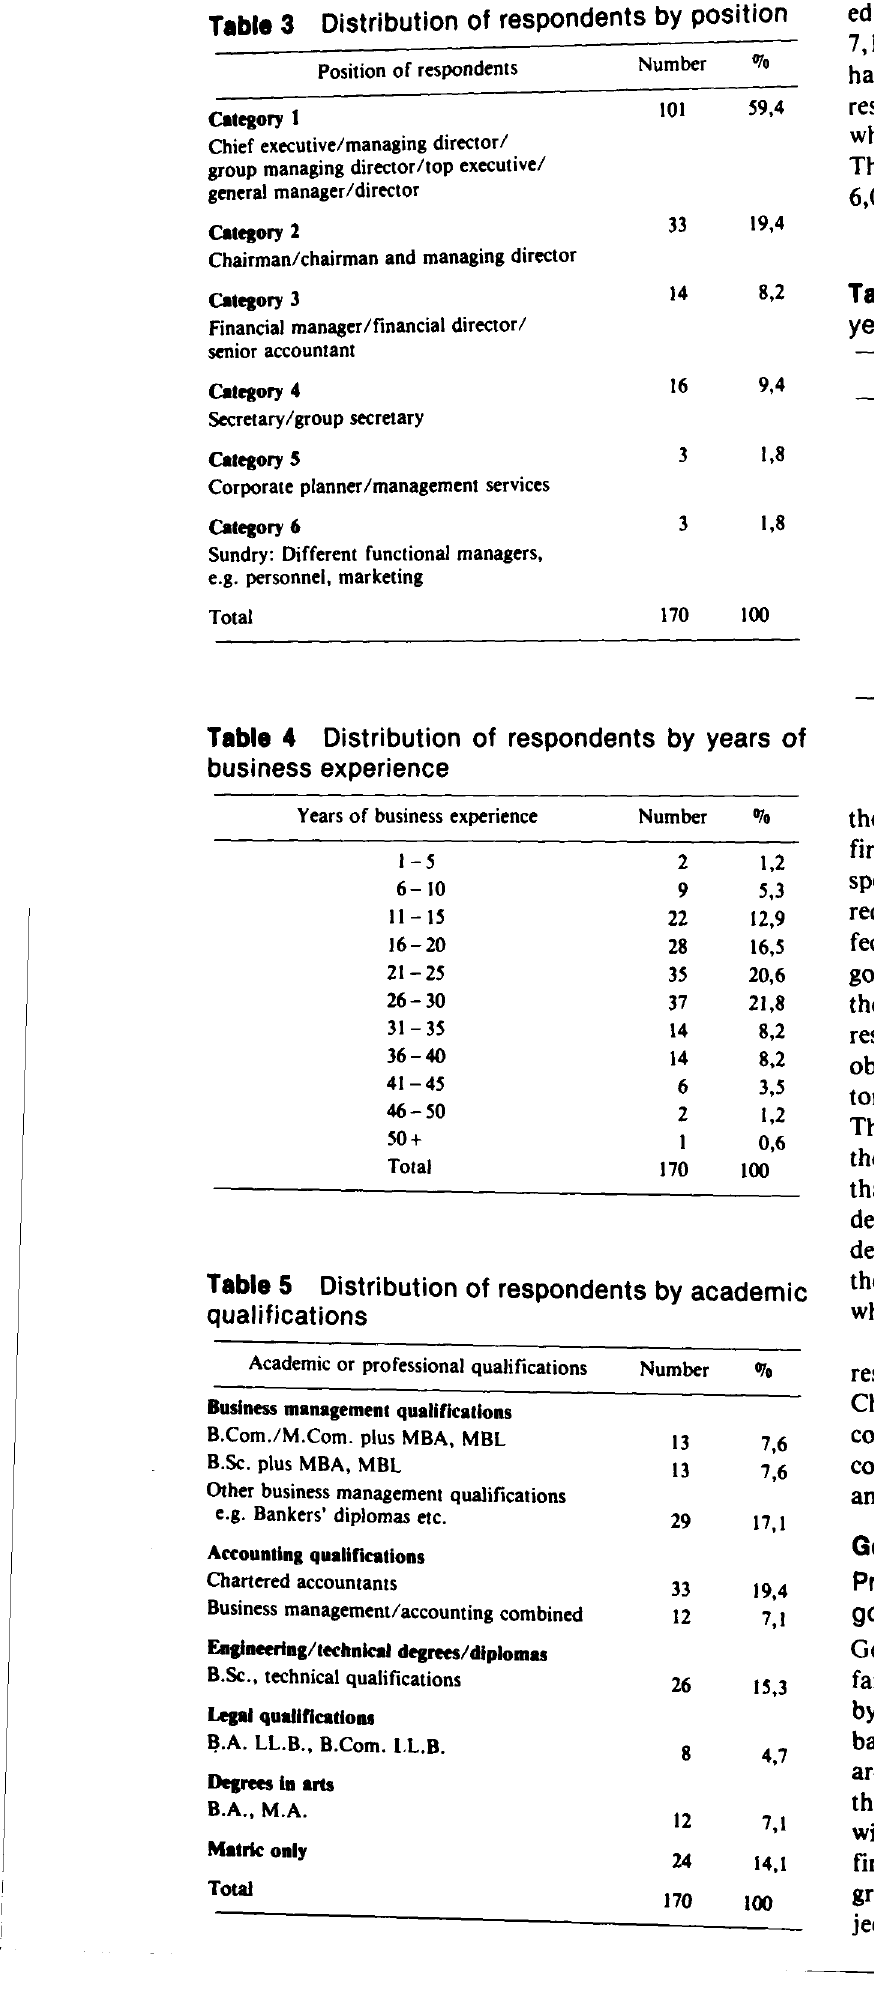
Distribution of respondents by position